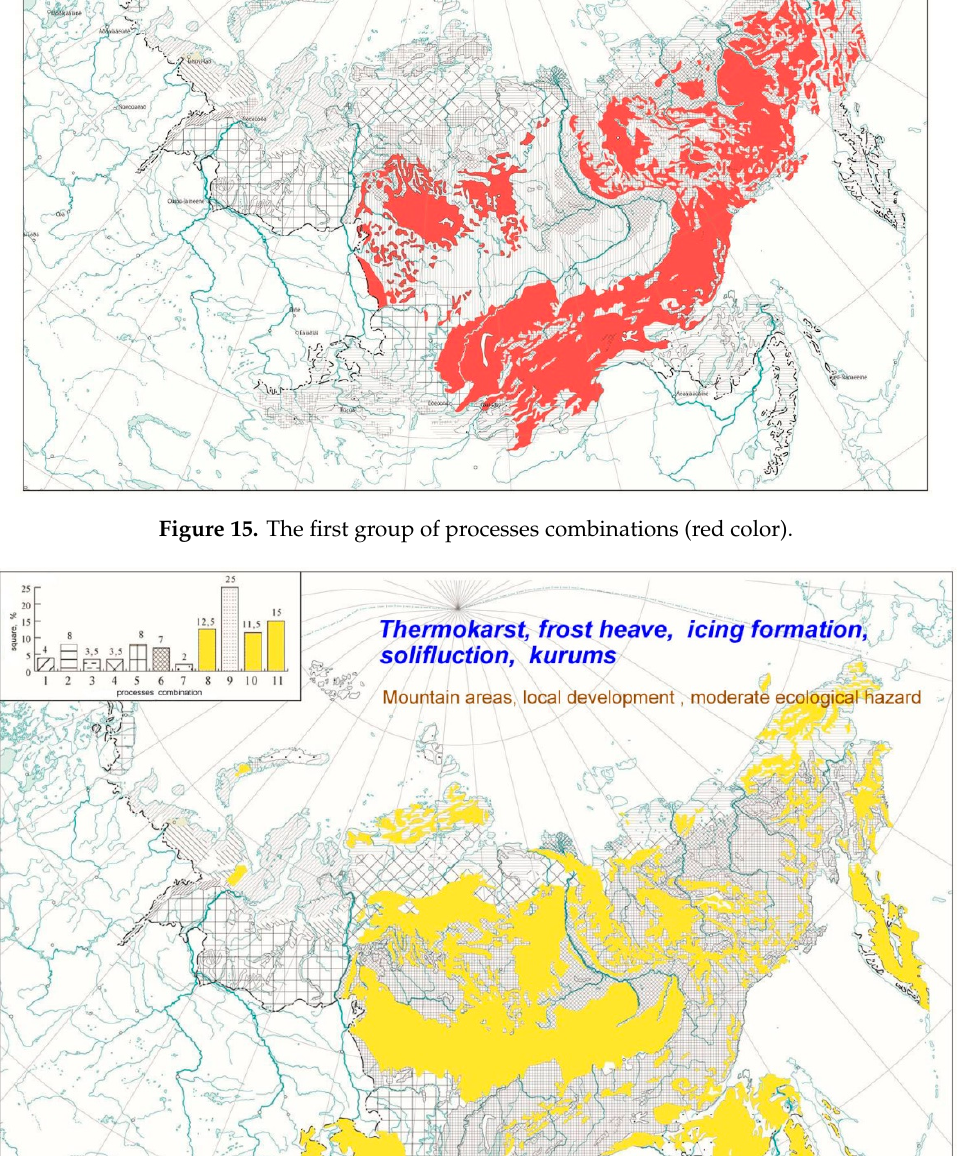
Figure 15. The first group of processes combinations (red color).